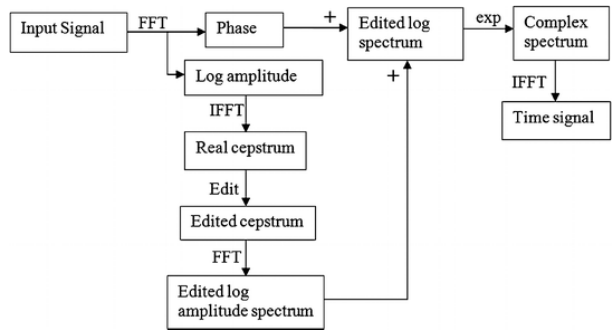
Figure 11. Schematic diagram of the cepstral method for removing harmonics from time-domain signals (Randall et al.,